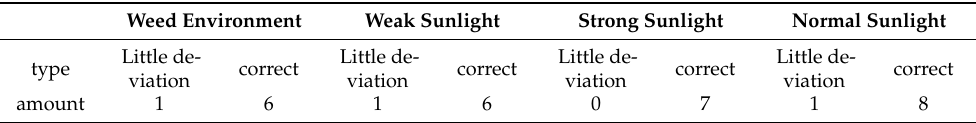
Table 4. The fitting of the centerline in fruit rows.